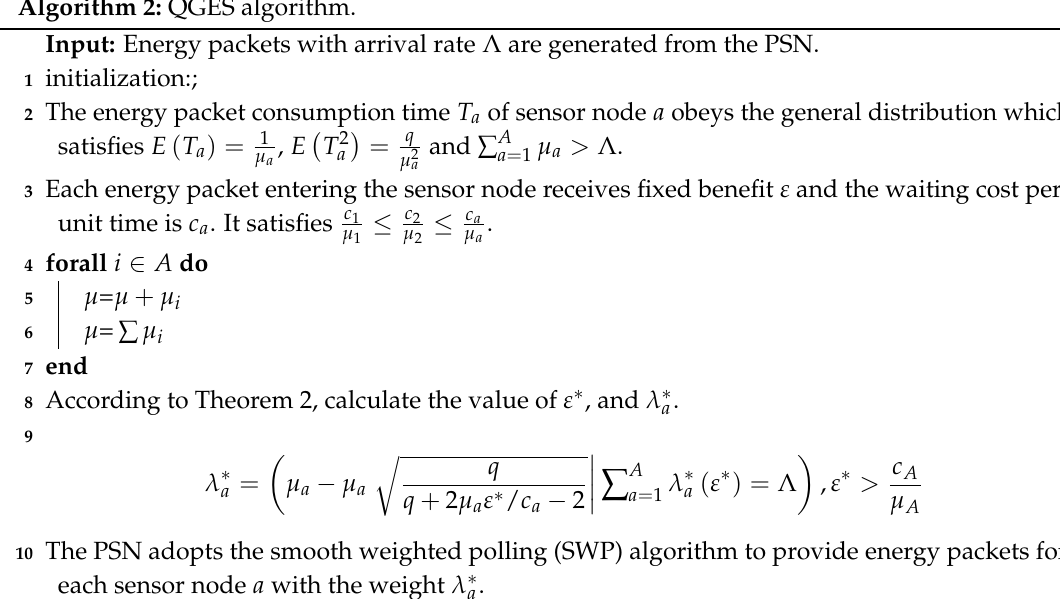
Algorithm 2: QGES